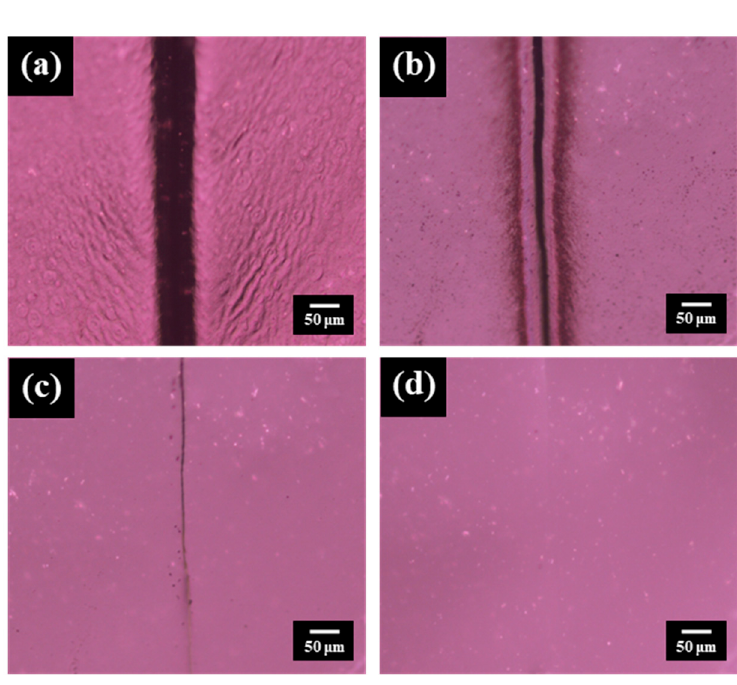
Figure 13. Optical microscope images recorded from the self-healing tests on a scratched DA-PEBF-2 sample at ( a ) room temperature, ( b ) 60 °C, ( c ) 120 °C and ( d ) 140 °C, respectively.